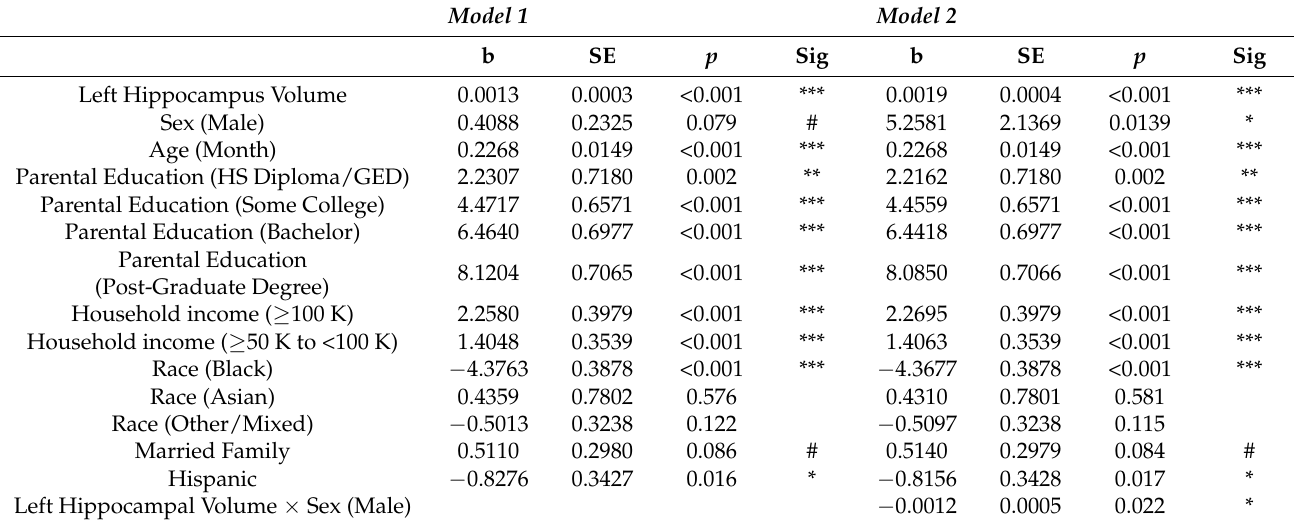
Table 4. Summary of coefficients on the effects of left hippocampal volume on list sorting working memory.